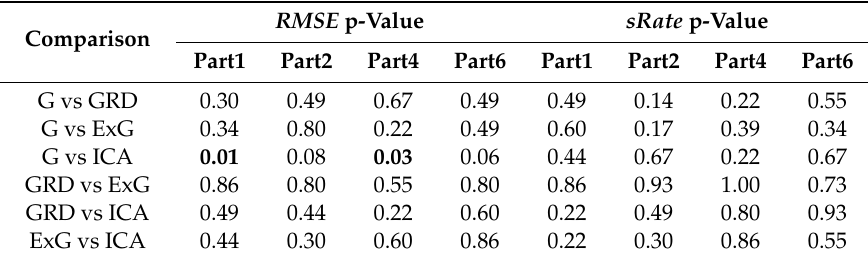
Table A9. The Wilcoxon rank sum test results (p-values) for comparing di ff erent signal extraction methods and activities, algorithm No.3